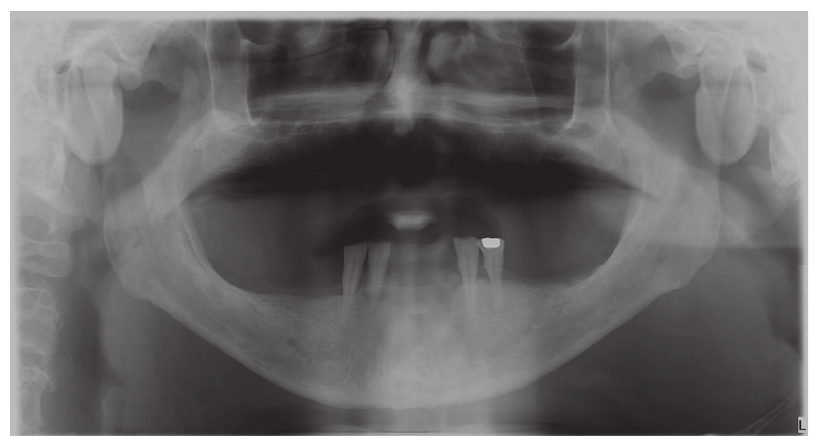
Figure 1: Preoperative panoramic radiograph.